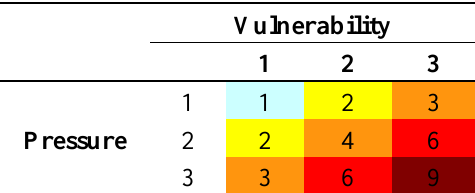
Table 3. Matrix of risk as a function of vulnerability and pressure